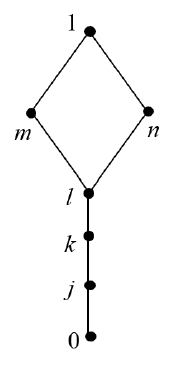
Figure 9. Lattice structure of Example